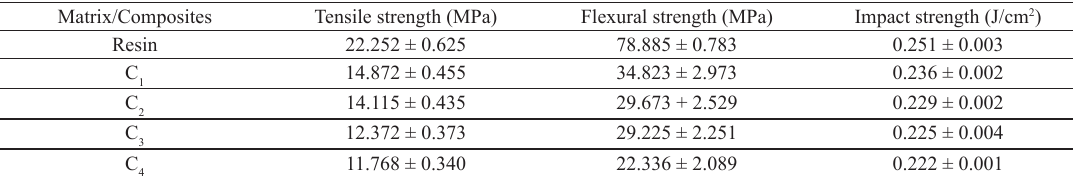
Table 3. Results of tensile, bending and impact tests for the composites and the polyester resin.